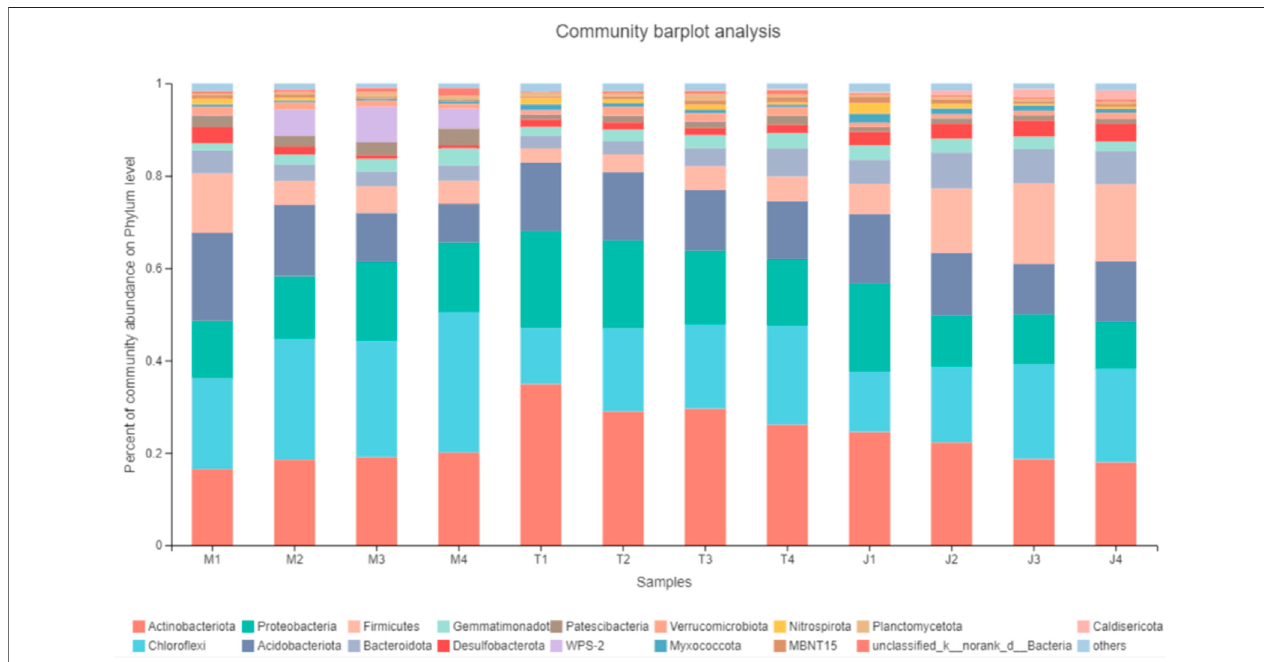
FIGURE 5 | Vertical distribution of bacterial species in peatlands across different permafrost regions (M1, M2, M3, and M4 represent the permafrost region of 0 – 10 cm, 10 – 30 cm, 30 – 50 cm and below 50 cm in Mohe, respectively; T1, T2, T3, and T4 represent the permafrost region of 0 – 10 cm, 10 – 30 cm, 30 – 50 cm and below 50 cm in Tahe, respectively; J1, J2, J3, and J4 represent the permafrost region of 0 – 10 cm, 10 – 30 cm, 30 – 50 cm, and below 50 cm in Jiagdaqi, respectively).